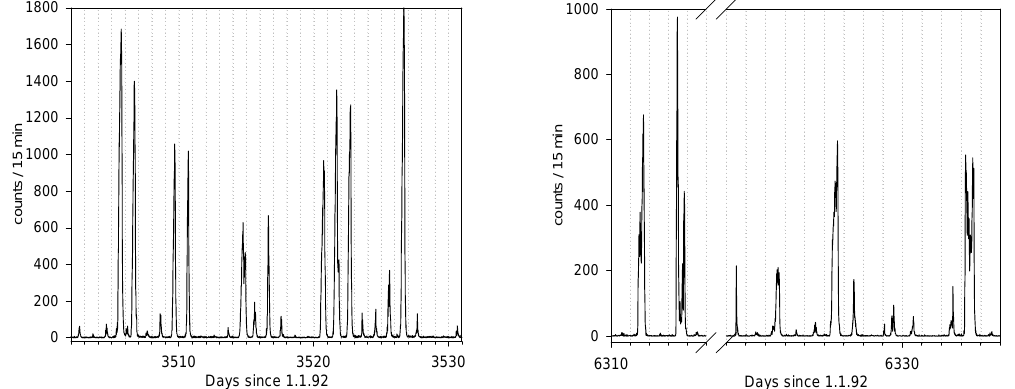
Figure 8: Distribution of peak time of SDR signals within the 24-hour diurnal cycle (Top). SDR peaks tend to occur between 15 and 16 hours (UT+2). The pattern is the same for SDR signals with low and high amplitudes (Bottom).